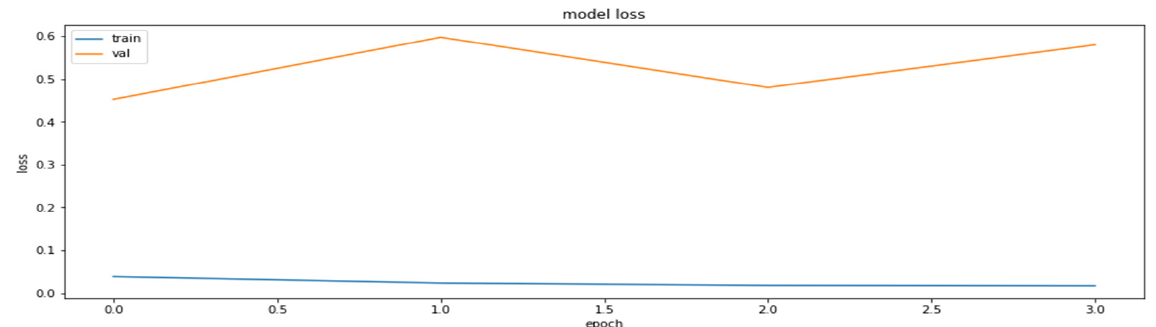
Figure 7. Training and validation datasets obtained during the application of the pruning part of the PCQAT.